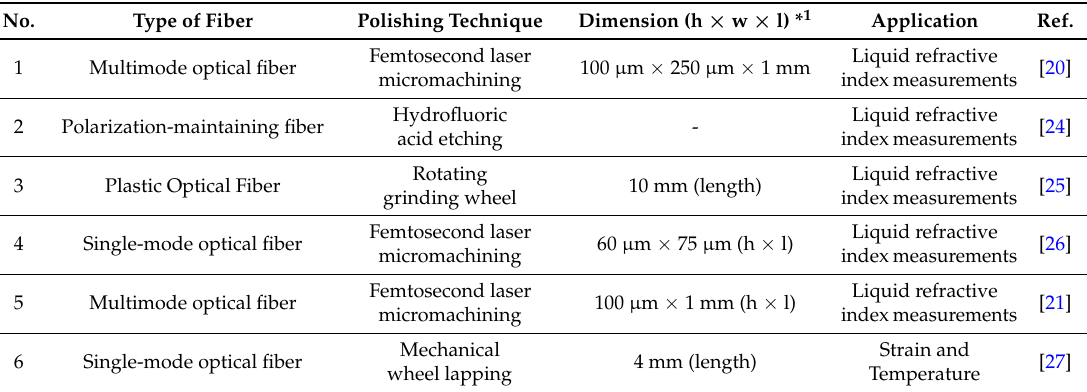
Table 1. Summary of D-shaped optical fiber